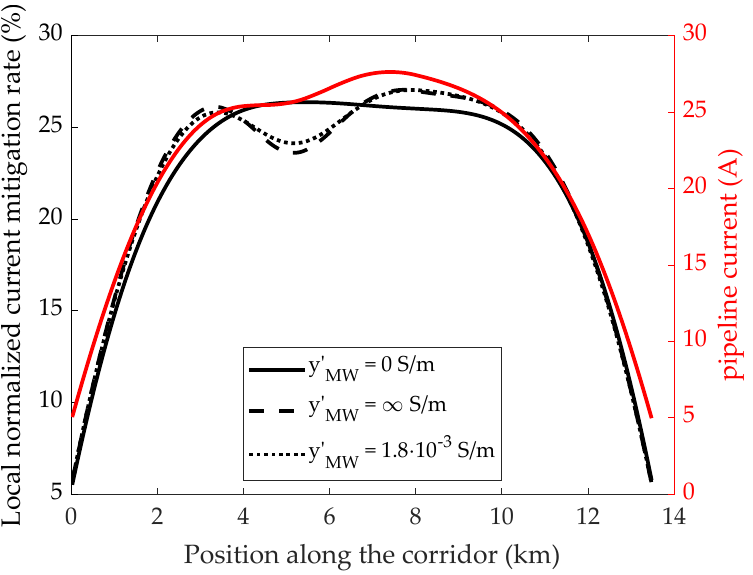
Figure 10. Normalized local current mitigation rate along the corridor for three different values of p.u.l. admittance to earth of the four (cylindrical) mitigation wires (left axis); unmitigated pipeline current (right